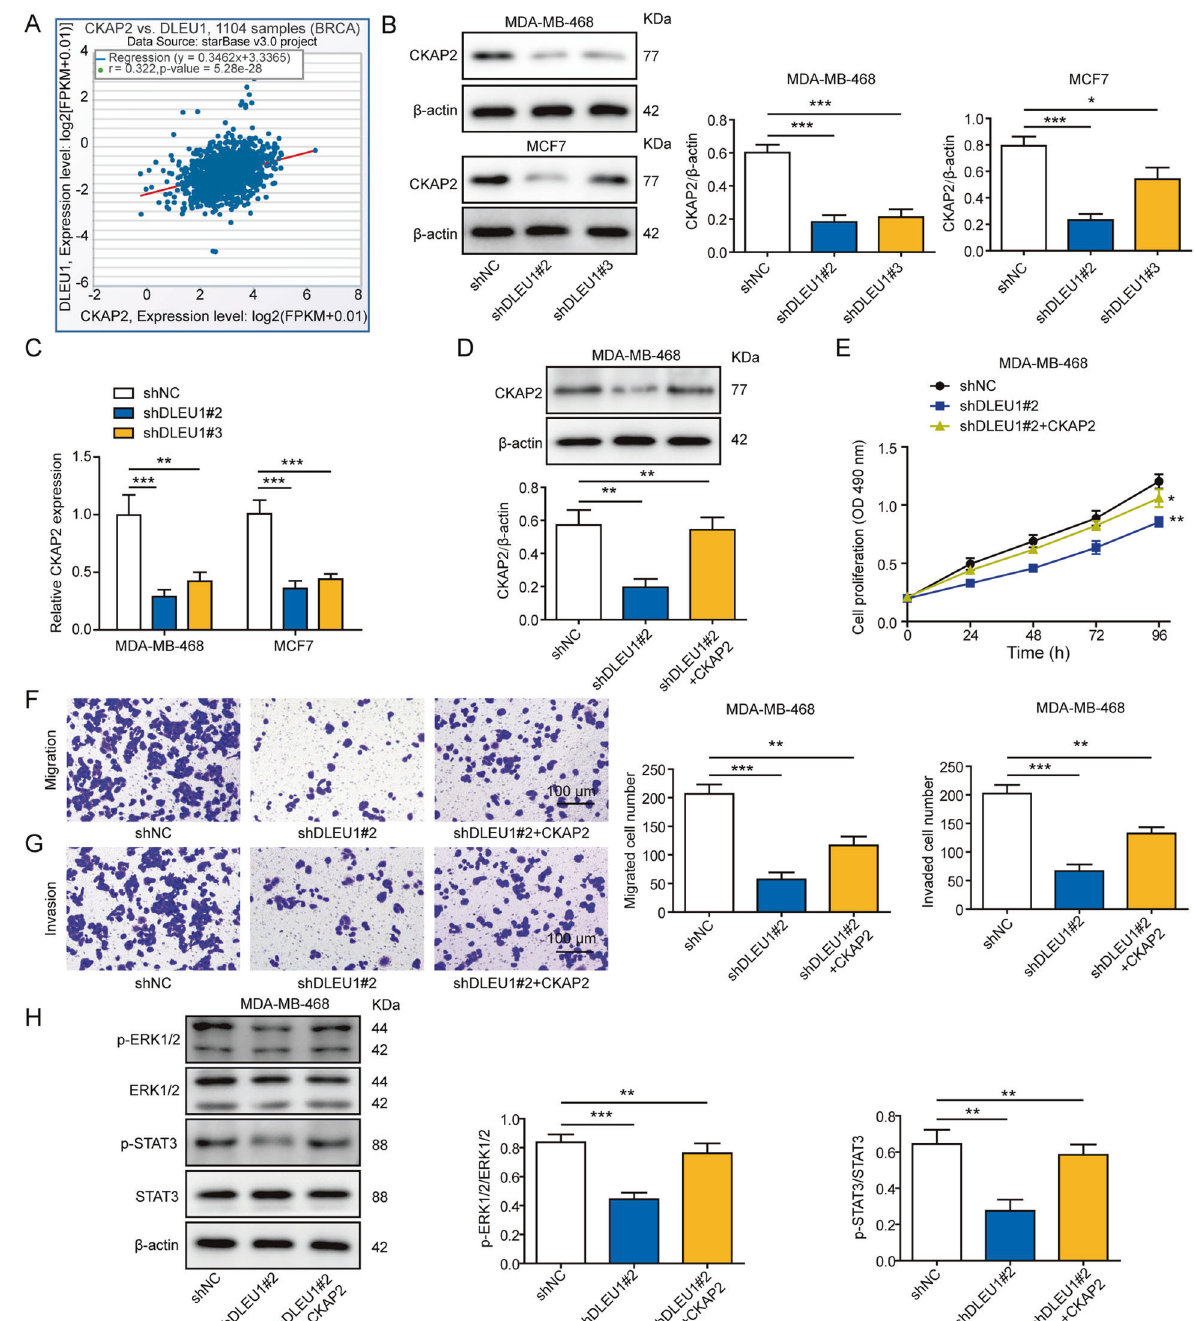
Fig. 3 Up-regulation of CKAP2 by DLEU1 is required for the pro-tumor activities of the latter. A Analysis of TCGA database revealed a signi fi cantly positive correlation between DLEU1 and CKAP2 expression levels in breast cancer tissues ( n = 1104). MDA-MB-468 and MCF7 cells were stably transfected with shNC, shDLEU1#2, or shDLEU1#3. The expression of CKAP2 was examined on the protein level by western blot ( B ) and on the mRNA level by RT-PCR ( C ). MDA-MB-468 and SK-BR-3 cells were stably transfected with shNC, shDLEU1#2, or shDLEU1#2 + CKAP2. CKAP2 protein ( D ), cell proliferation ( E ), migration ( F ), invasion ( G ), and expressions of p-ERK1/2, ERK1/2, p-STAT3, and STAT3 ( H ) were examined by western blot, MTT assay, Transwell migration, Transwell invasion, and western blot, respectively. * P < 0.05, ** P < 0.01, *** P < transcription of target genes. Although no previous study has #3 cells and shNC cells (Fig. 4E). These data support that DLEU1 demonstrated CKAP2 as a direct target for HIF-1 α , analysis of directly interacts with HIF-1 α , but not controls its expression. JASPAR database revealed a HRE within the promoter of human CKAP2 gene (Fig. 5A). TCGA analysis of 1104 breast cancer DLEU1 is a co-factor required for HIF-1 α -induced transcription of CKAP2 The direct interaction between DLEU1 and HIF-1 α suggests that DLEU1 may function as a co-factor and regulate HIF-1 α -controlled